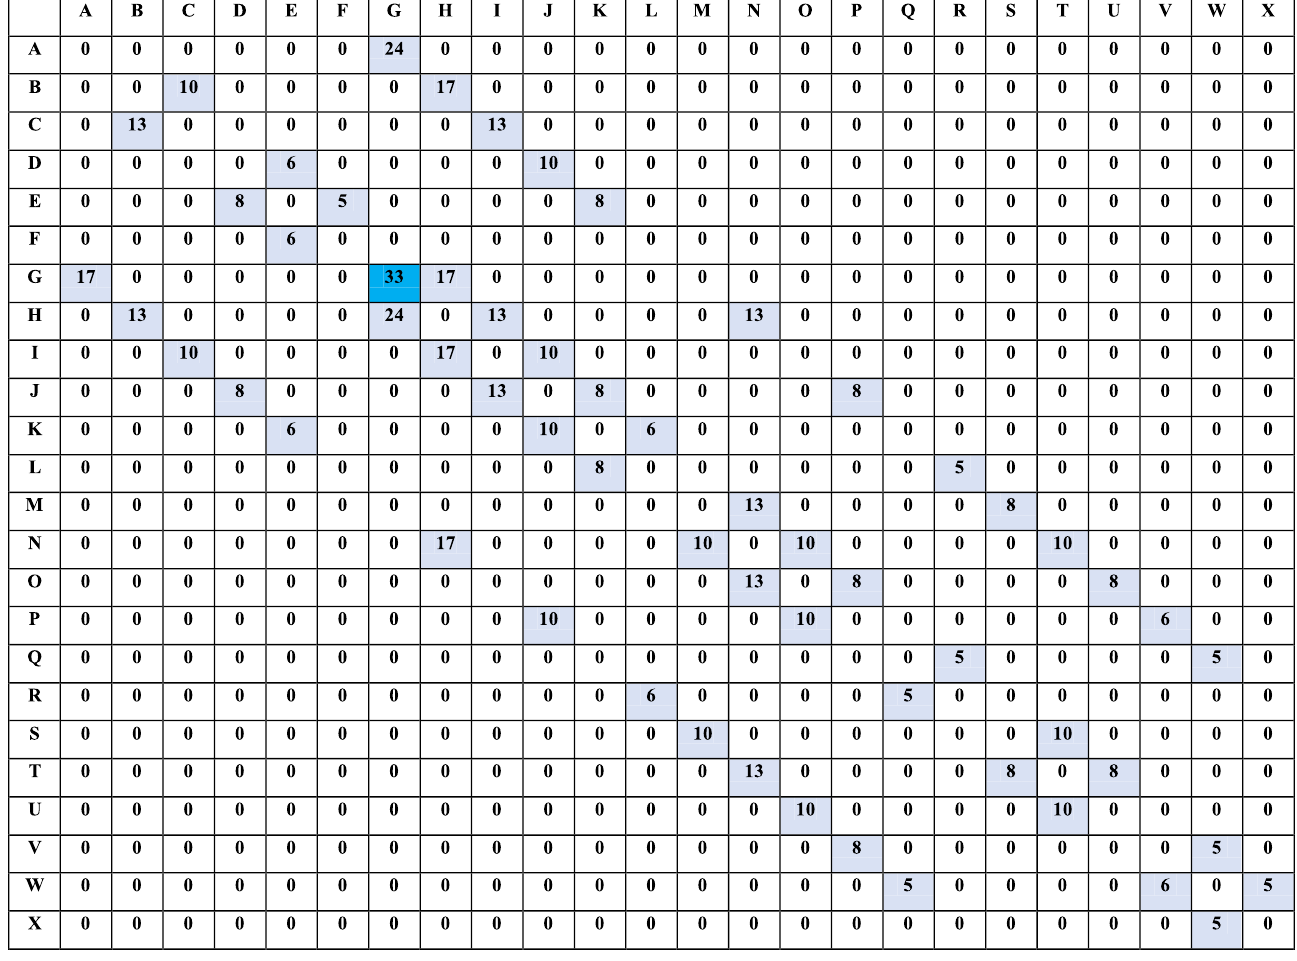
Figure 5. Autonomous robot Q Table for safety response in segment 1